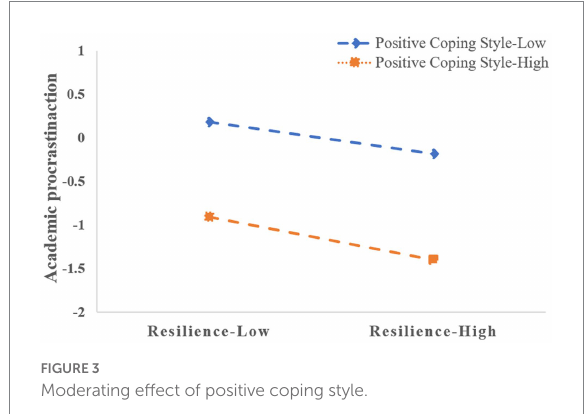
FIGURE 3 Moderating effect of positive coping style.